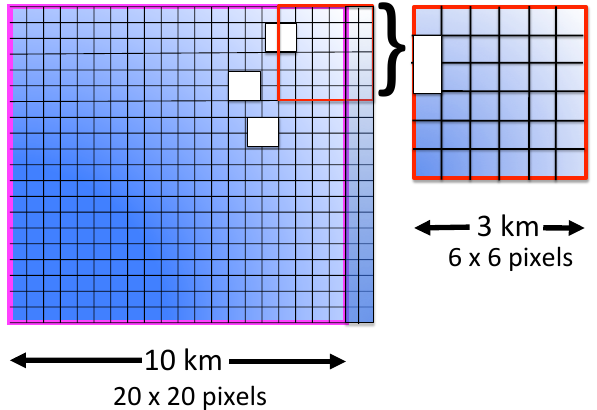
Fig. 1. Illustration of the organization of the MODIS pixels into retrieval boxes for (left) the 10km product consisting of 20 × 20halfkm pixels within the magenta square and (right) the 3km product consisting of 6 × 6halfkm pixels within the red square. The small blue squares represent the 0.5km pixels. The white rectangles represent pixels identified as cloudy. The 3km retrieval box is inde- pendent of the 10km box, and is not a subset. Here it is shown